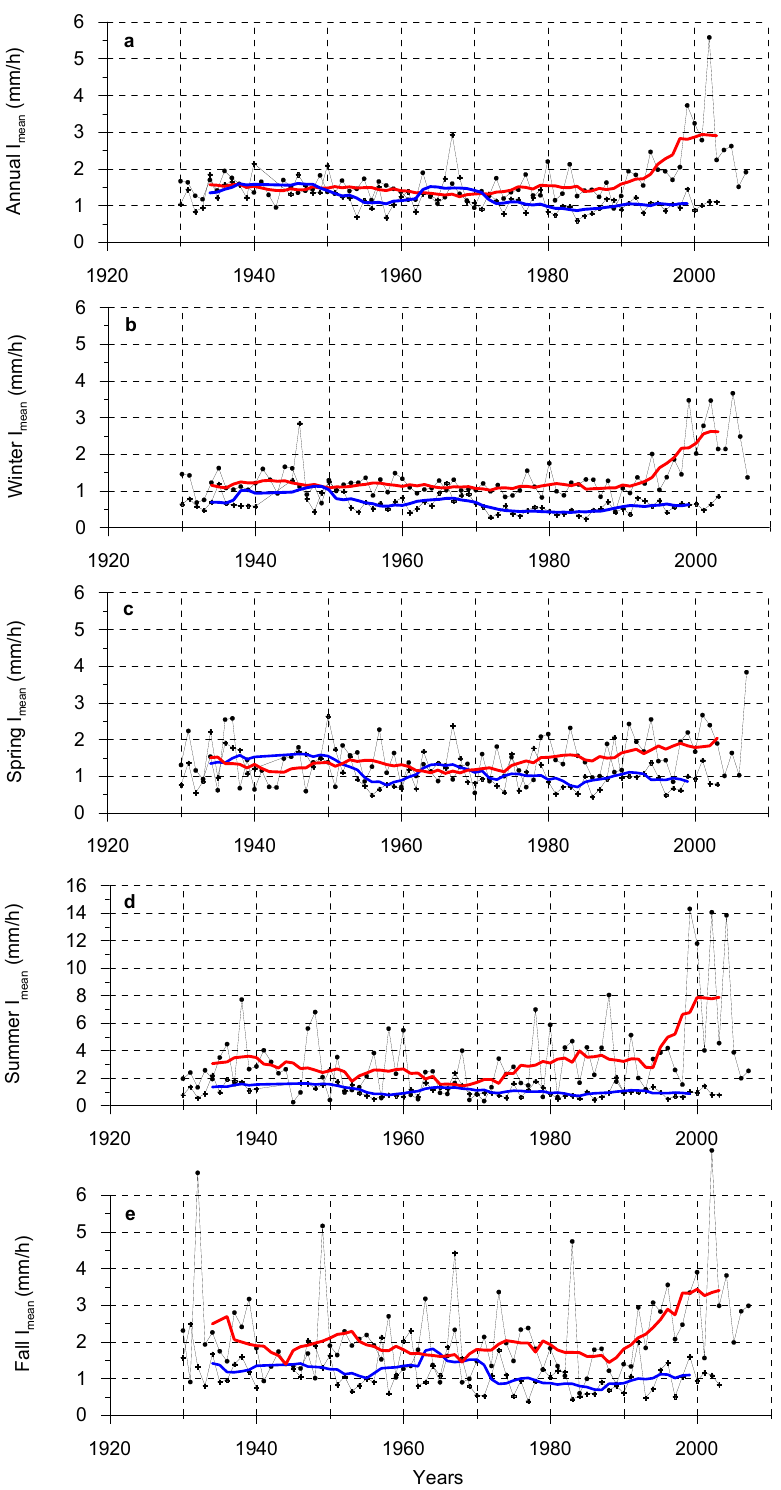
Figure 2. Time series of annual and seasonal mean rain intensity I mean for NOA ( ● circle) and AUTH (+cross). Red (NOA) and blue (AUTH) curves represent the Gaussian 9 fitting filter. Fig. 2. Time series of annual and seasonal mean rain intensity I mean for NOA ( • circle) and AUTH (+ cross). Red (NOA) and blue (AUTH) curves represent the Gaussian 9 fitting